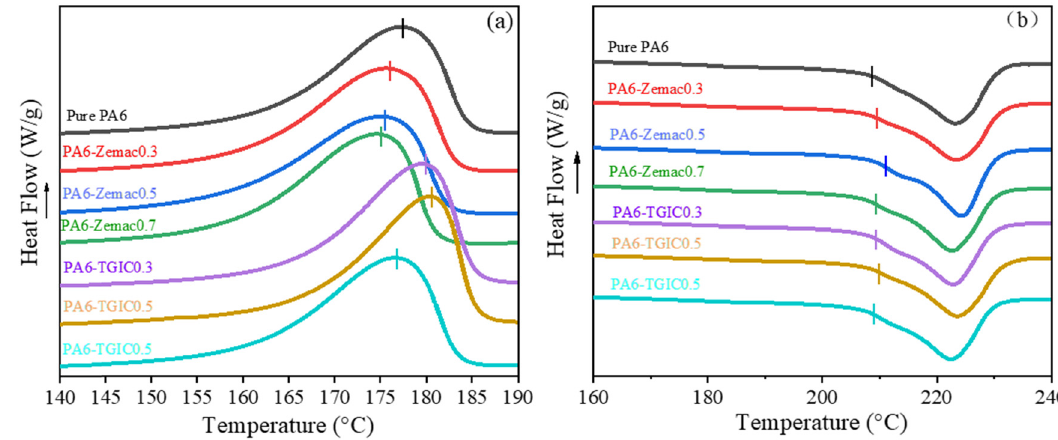
Figure 5: DSC graphs of pure PA6 and modi fi ed PA6 samples: ( a ) cooling crystallization curves and ( b ) heating melting